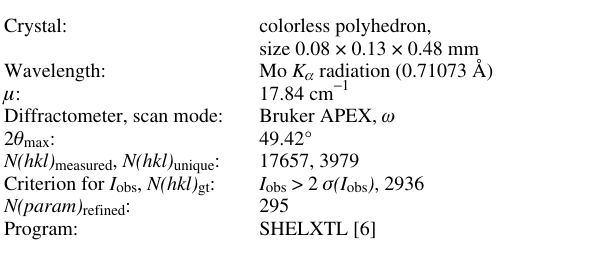
Table 2. Continued . Table 1. Data collection and